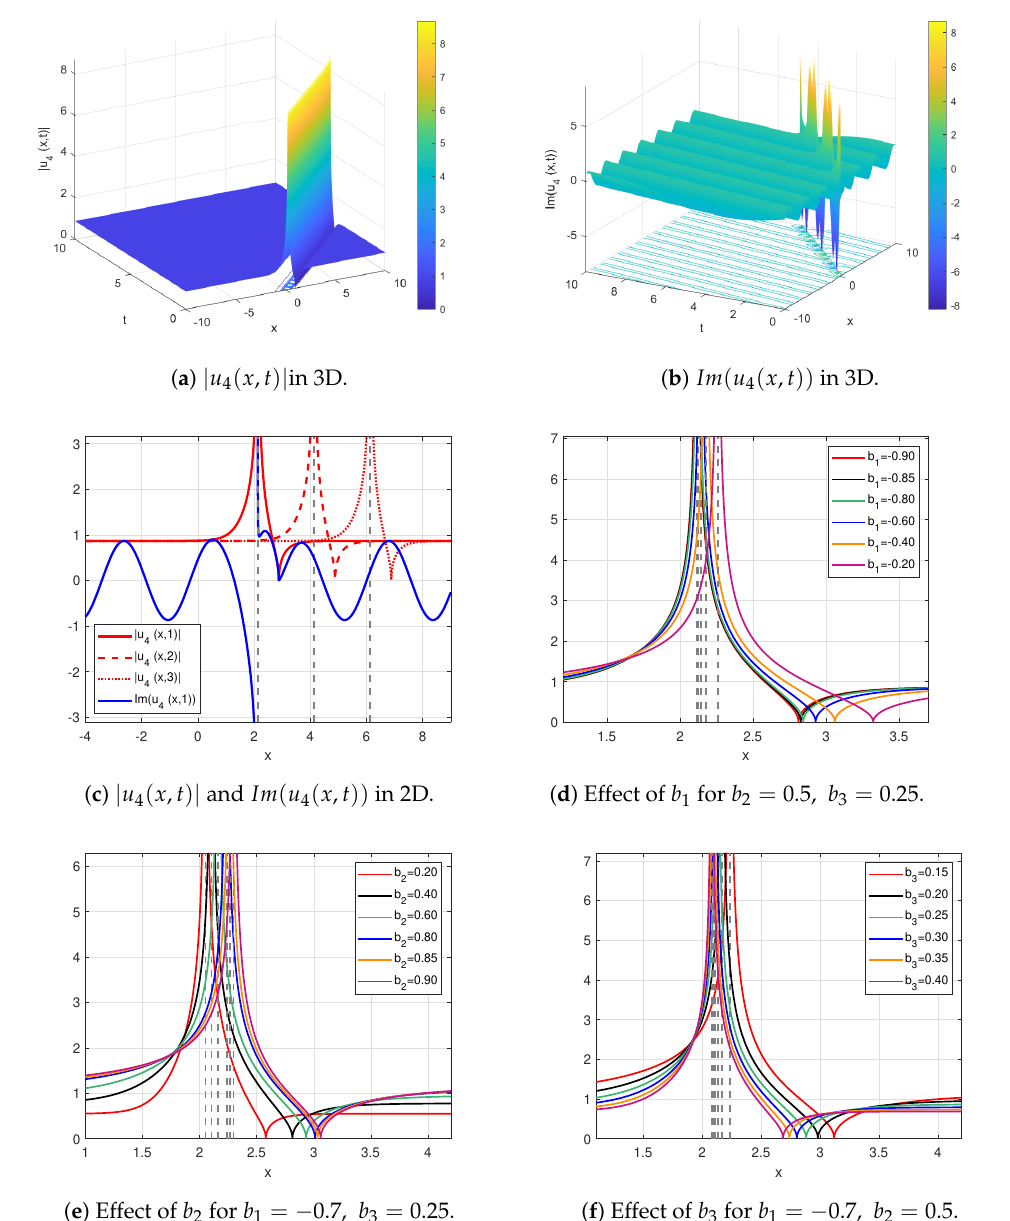
Figure 4. The various projections of u 4 ( x , t ) in Equation (22) by combination of the Set 4 in Equation (15) and the selected h = − 0.04, a = − 0.5, φ 0 = 0.5, b 1 = − 0.7, b 2 = 0.5, b 3 = 0.25, κ = 2 values. In Figure 5, we presented a different singular soliton shape of u 8 ( x , t ) in Equation (26) by using the Set 5 in Equation (16) and the selected h = 0.04, a = 0.5, φ 0 = 0.5, b 1 = − 0.7, b 2 = 0.5, b 3 = 0.25, κ = 2. Figure 5a,c (red lines) portray the periodic singular shape of | u 8 ( x , t ) | , while Figure 5b,c (blue line) reflect the strange singular shape. Figure 5d–f are the figures that show the effect of b 1 , b 2 and b 3 , respectively. Depending on the b i ( i = 1, 2, 3 ) , in Figure 5d the soliton moves to the right, in Figure 5e,f the soliton moves to the left. As an even more important detail, the horizontal amplitude of the soliton increases when moving to the right (Figure 5d), and decreases when moving to the left (Figure